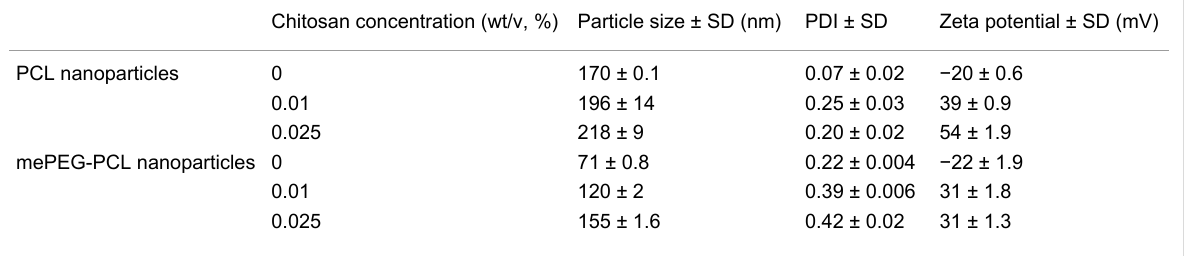
Table 3: The effect of chitosan concentration on the physicochemical properties of blank PCL and mePEG-PCL nanoparticles ( n = 3 ±